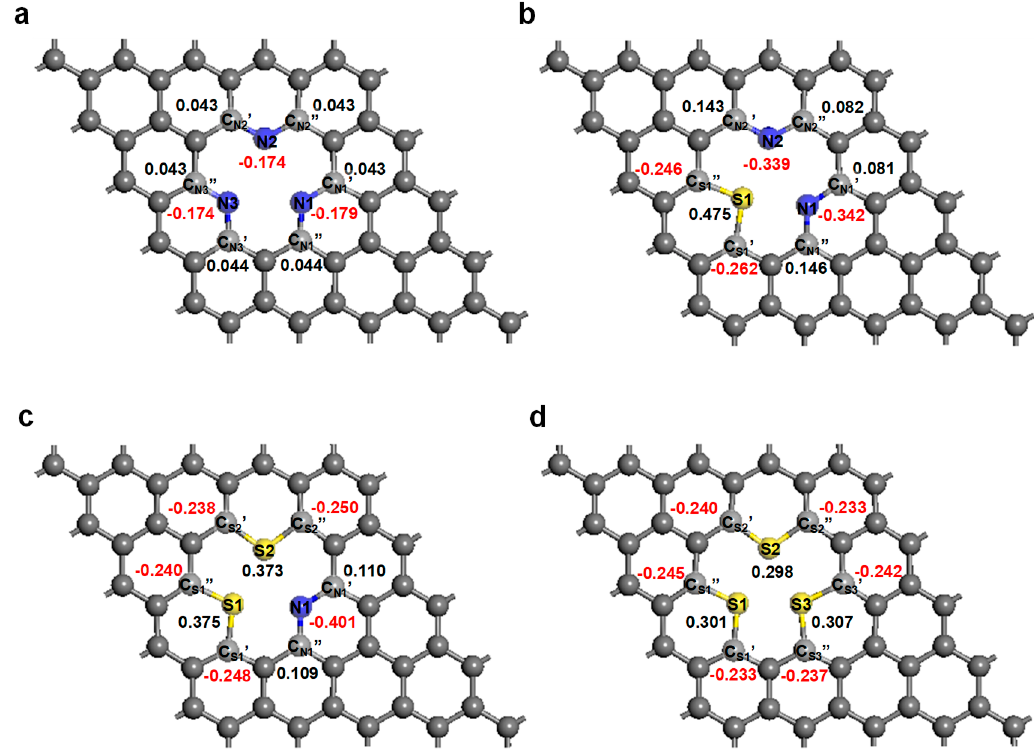
Figure 3. Calculated charge-density distributions on the atoms around the doped mono-vacancy region for the ( a ) 3N-gra, ( b ) 2N1S-gra, ( c ) 1N2S-gra, and ( d ) 3S-gra systems. Blue, gray, and yellow denote nitrogen, carbon, and sulfur, respectively.